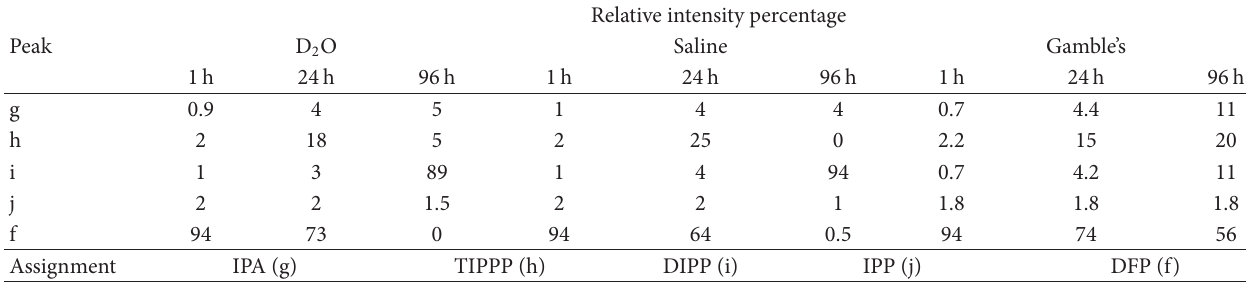
T 5: Comparison of methyl-peak intensities of DFP reaction products.